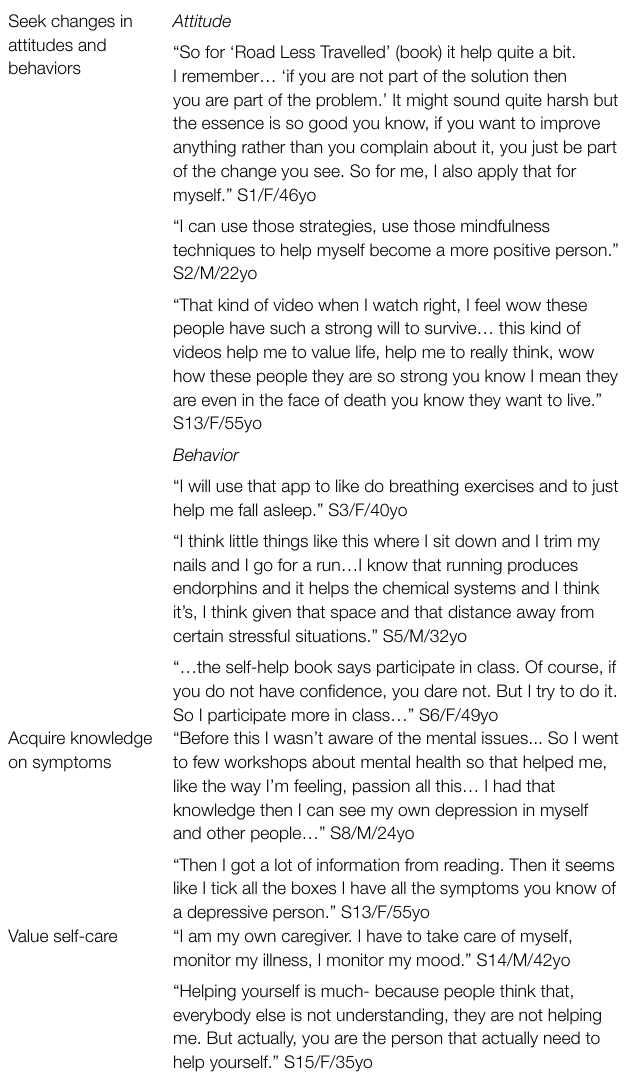
TABLE 2 | Reasons for engaging in self-help